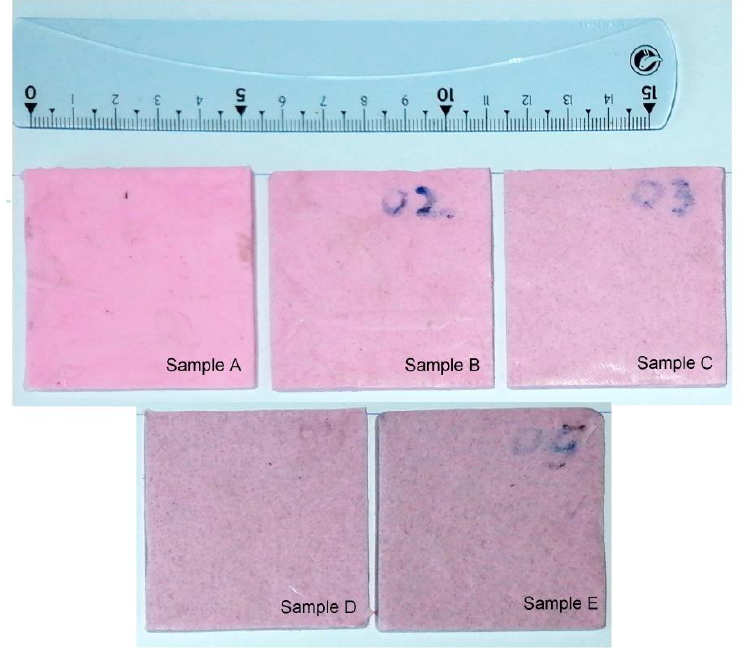
Figure 2. The images of the SR—xAl composite samples of silicone rubber with Al particles (x— volume fraction of Al particles): sample A (x = 0); sample B (x = 0.005); sample C (x = 0.01); sample D (x = 0.025); and sample E (x =